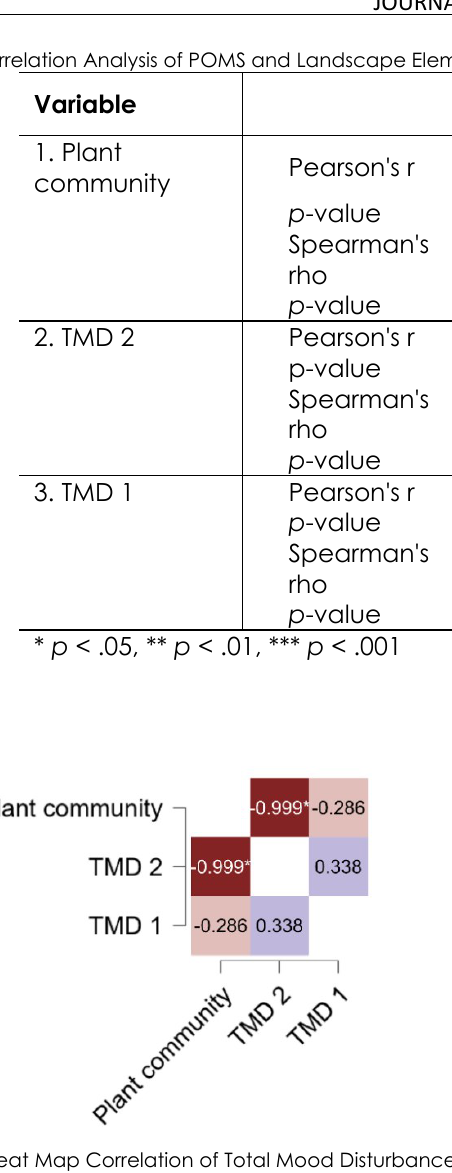
Figure 6 . Heat Map Correlation of Total Mood Disturbance and Landscape Elements of Park